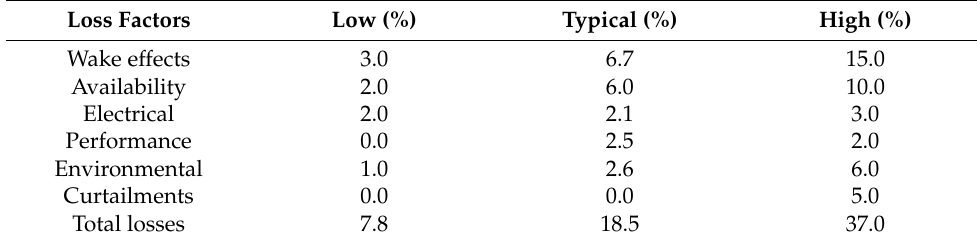
Table 2. Loss factors of wind farm